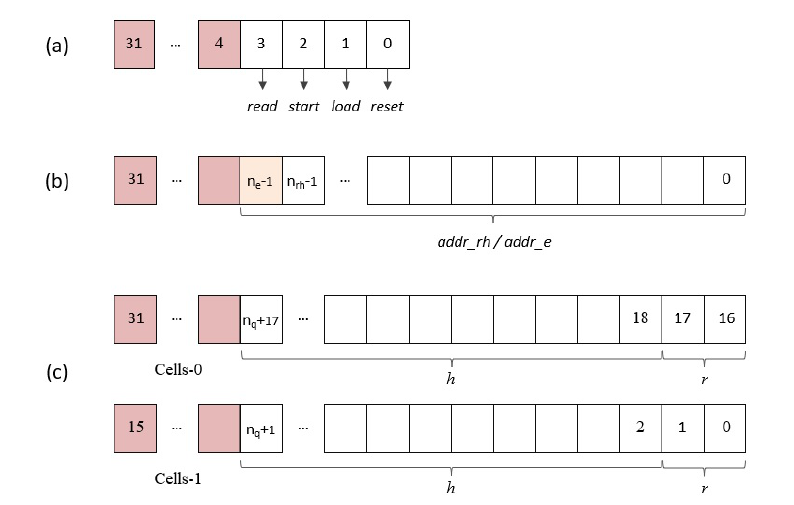
Figure 10. AXI4-Lite IP module input registers: ( a ) control register; ( b ) address register; and ( c ) data input register.